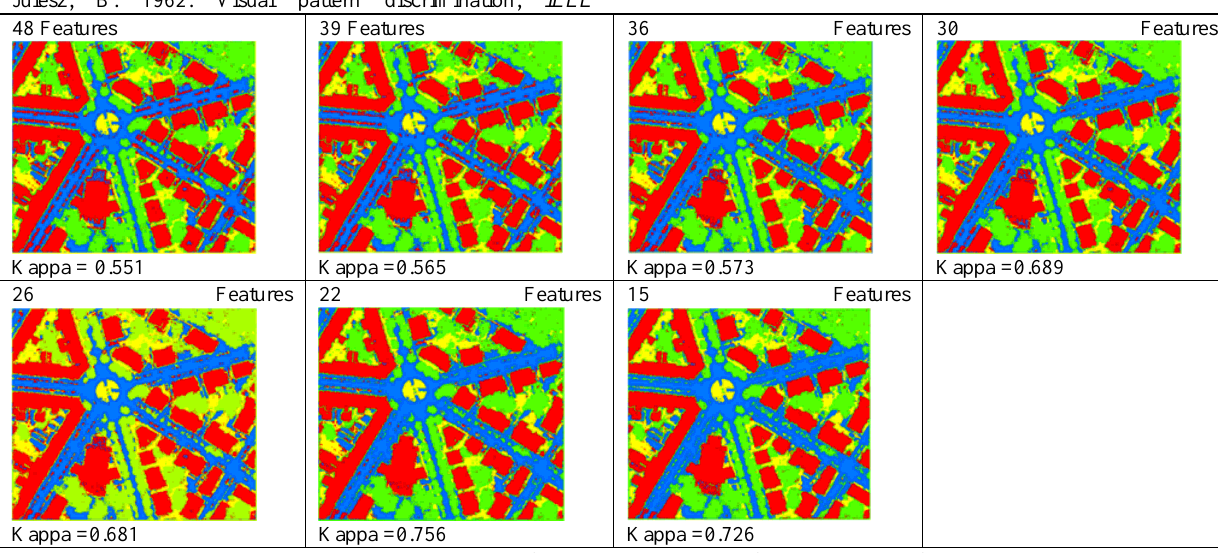
Figure 5. the Maximum Likelihood classification results based on feature selection of Random